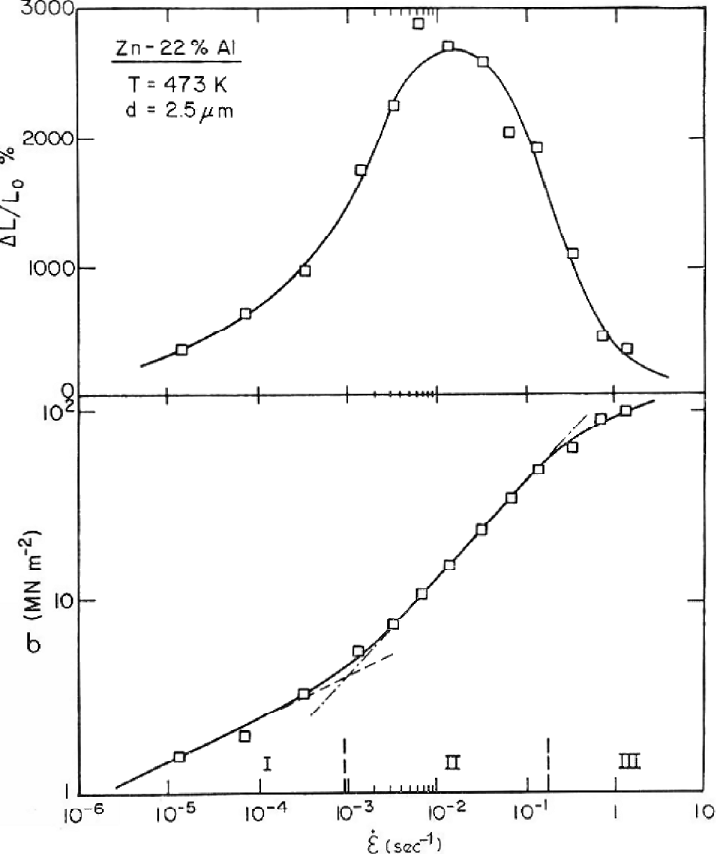
Fig. 1. Elongation to failure (upper) and flow stress (lower) versus initial strain rate for a Zn-22% Al eutectoid alloy having an average spatial grain size of 2.5  m pulled in tension at a testing temperatures of 473K